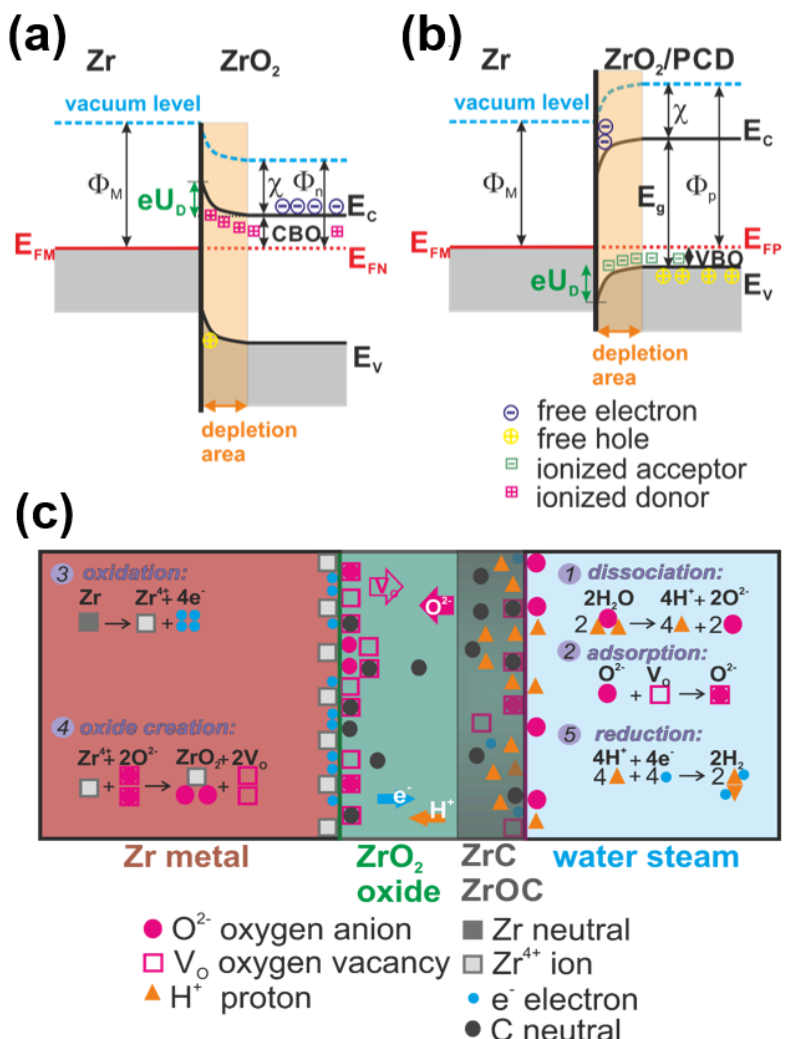
Figure 7. ( a ) Schottky barrier at the n-type semiconductor/metal interface. ( b ) Schottky barrier at the p-type semiconductor/metal interface. U D is barrier voltage, Φ M is the work function of the metal (Zr), χ is the semiconductor (ZrO 2 ) electron affinity, and Φ n/ Φ p is the semiconductor work function. ( c ) Scheme of the corrosion process in diamond coating on zirconium alloys. First, oxygen in the water molecule dissociates and is adsorbed onto the oxide layer surface at an oxygen vacancy site. Because of the defect concentration gradient and the electric potential across the oxide, the oxygen anions diffuse and react with zirconium cations to form new oxide. The formation of this new oxide releases electrons, which interact with the hydrogen ions at the cathodic site.